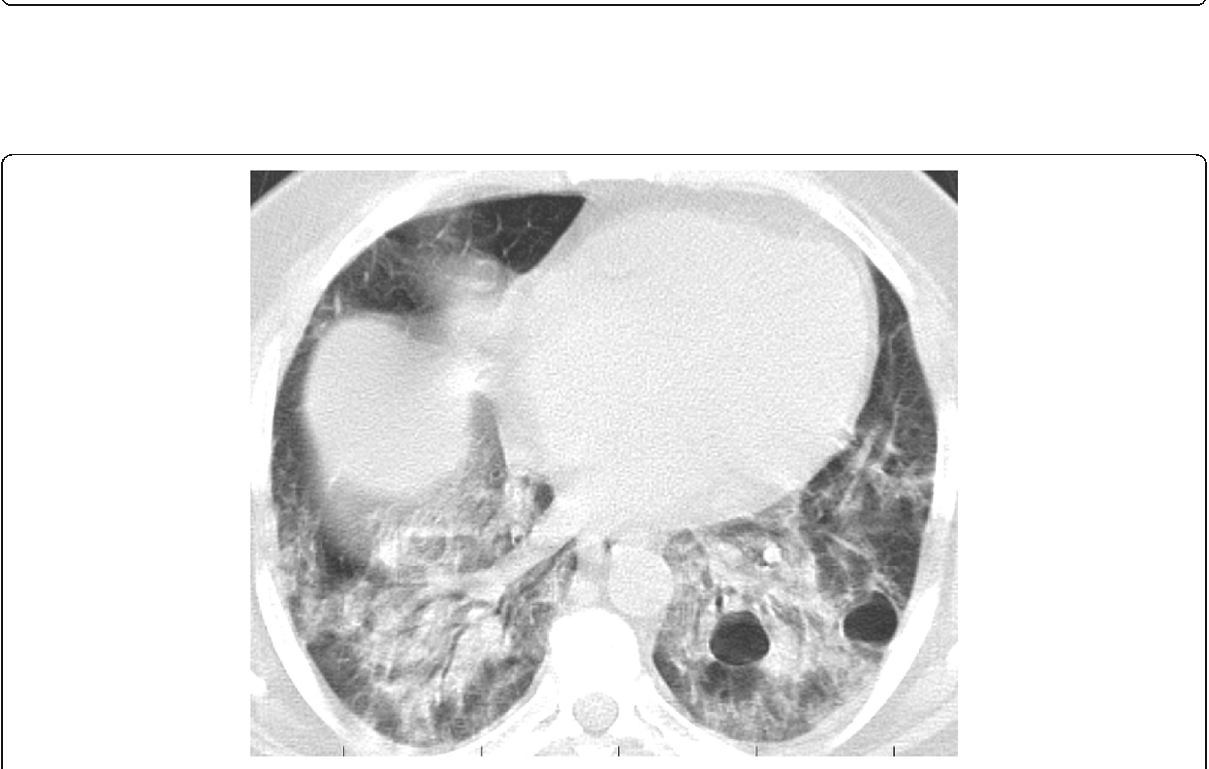
Fig. 19 A 27-year-old male patient with COVID-19. CT chest axial images ( a ) and ( b ) and coronal image ( c ) show two subpleural masses showing “ vacuolar ” sign